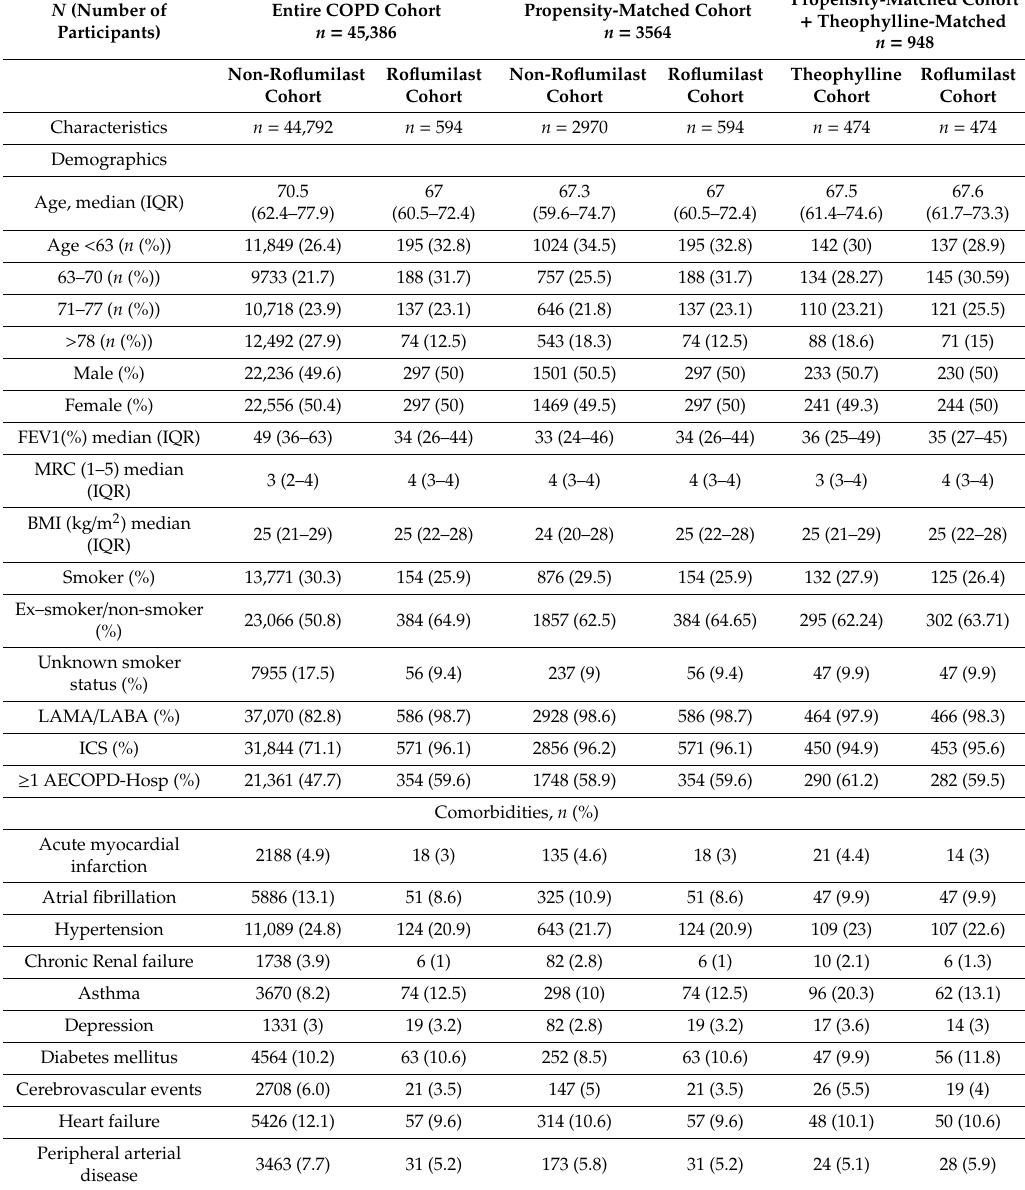
Table 1. The demographic and clinical characteristics for the entire population, the propensity-matched population and the theophylline matched